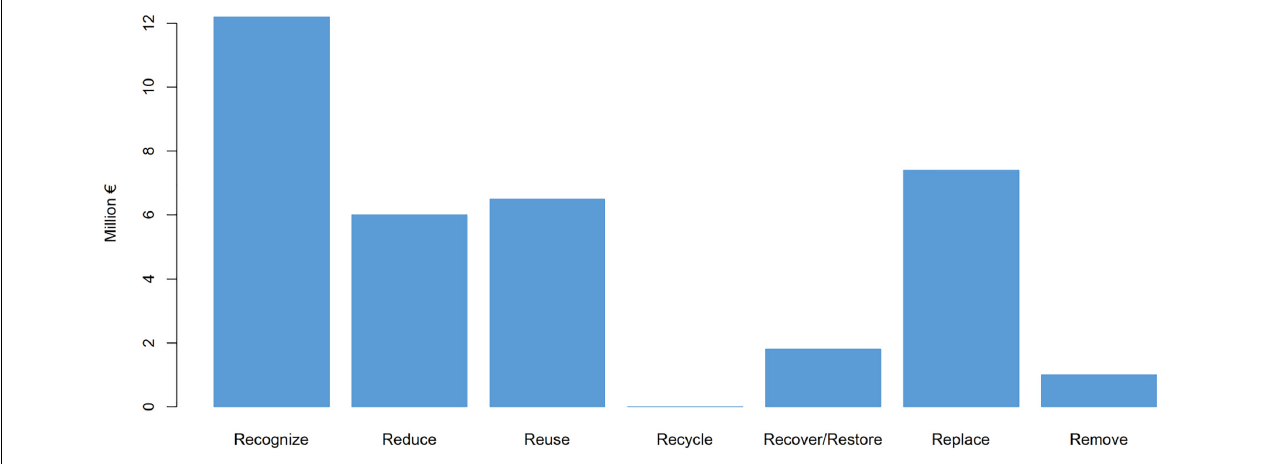
FIGURE 2 | EU funding contributions categorized under the 8Rs